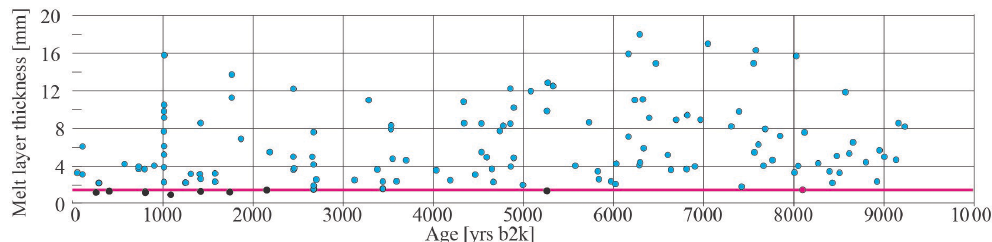
Figure A4. Thinning-corrected melt layer thicknesses (circles). Black circles were removed from the record due to the cutoff at 1.54mm (pink circle and line).